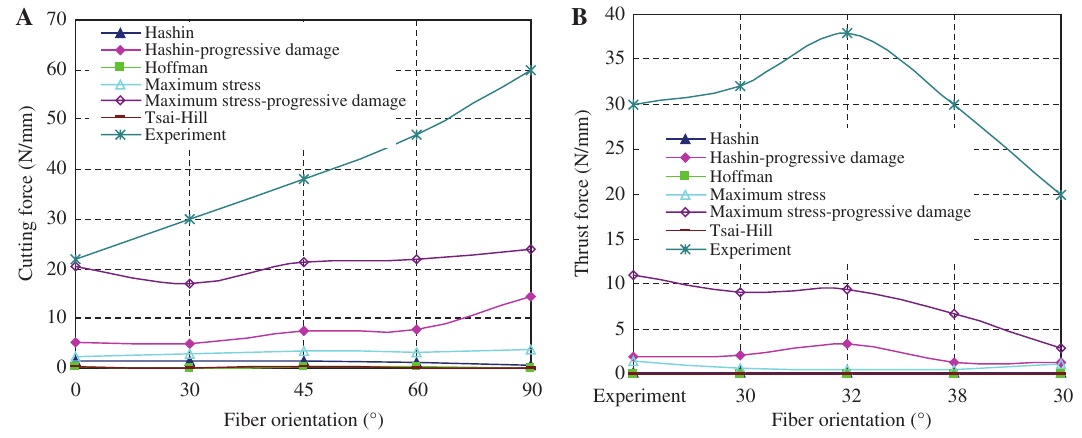
Figure 8: Influence of damage models on average cutting